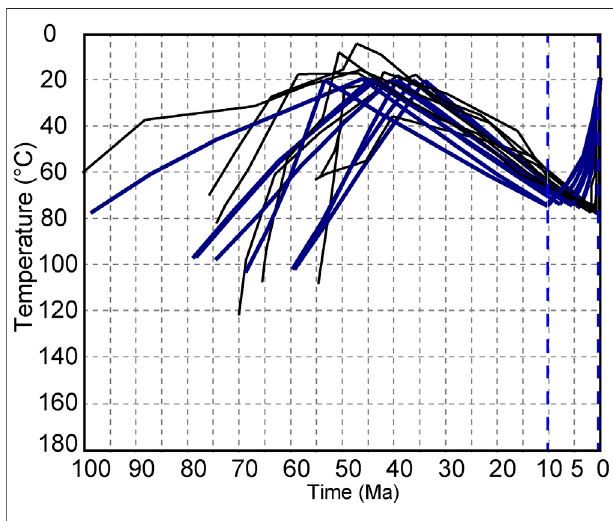
FIGURE 9 | Modeled weighted mean and best fi t thermal paths for all samplesderivefrom Figure8 .Thelegendsarethesamewiththatin Figure8 .